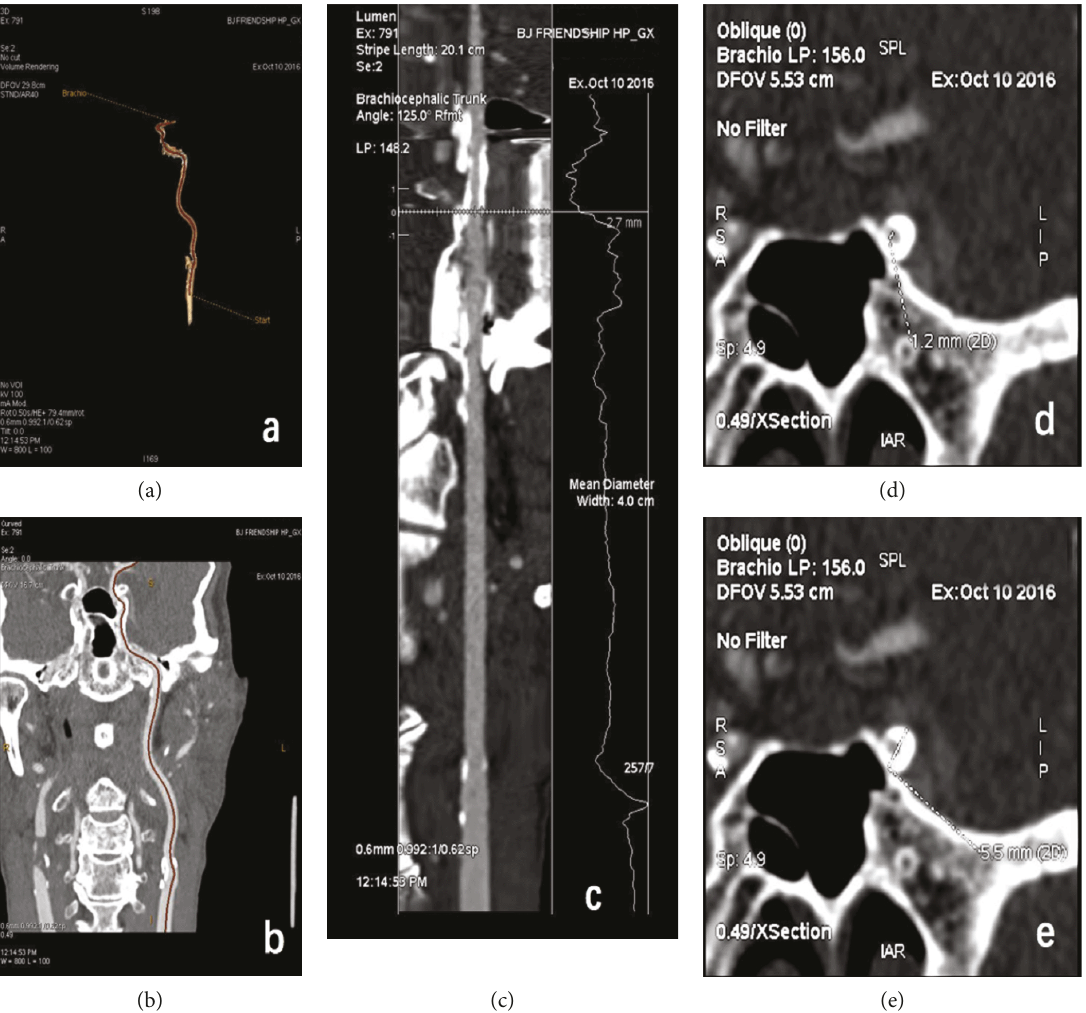
Figure 1: Head and neck CTA inspection. (a, b) The ICA trajectory. (c) Five segments of ICA blood vessels were measured in this study, and the measurement data of the narrowest blood vessel was selected. (d) shows the narrow vessel diameter, and (e) shows the normal vessel diameter; vascular stenosis degree %=normal vessel diameter − narrow vessel diameter, divided by the normal vessel diameter ×